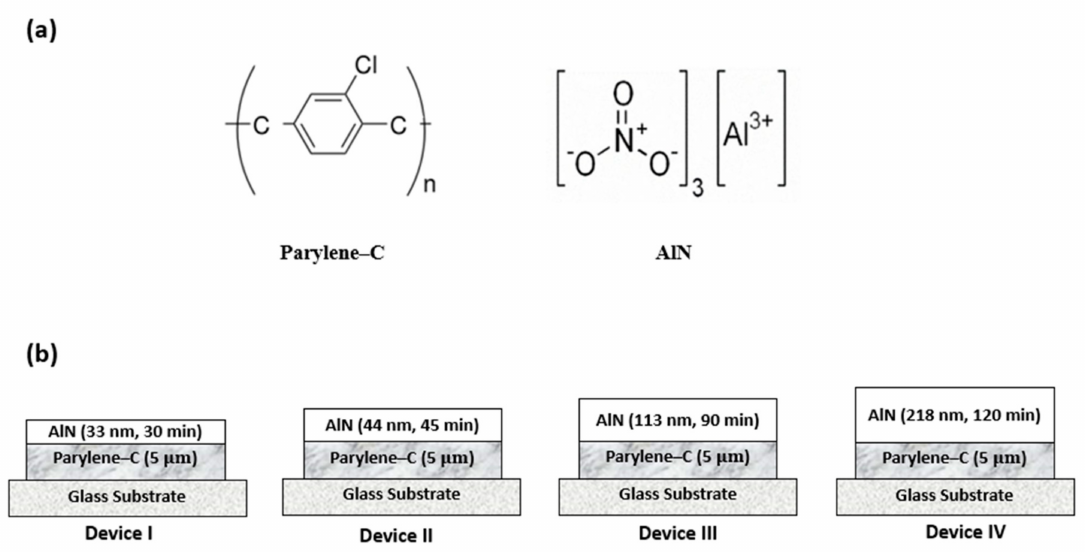
Figure 1. ( a ) The chemical structure of Parylene-C and AlN. ( b ) The schematic structures of AlN deposited on Parylene-C with respect to sputtering